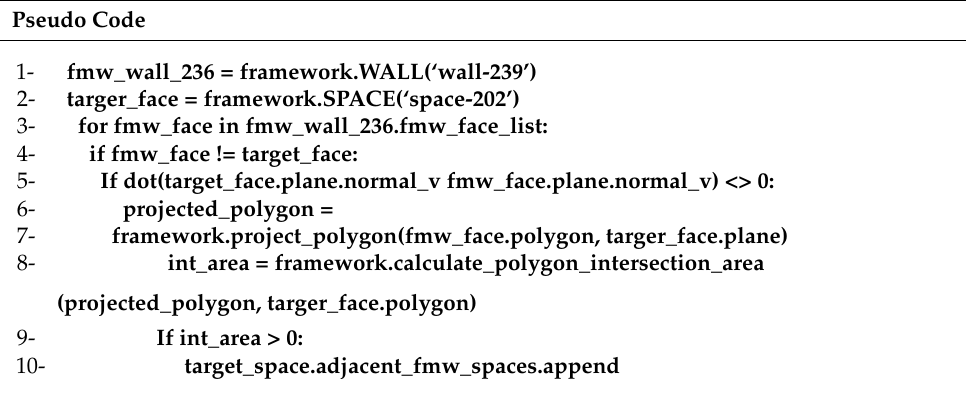
Table 5. Extracting the space’s bounded walls using semantic query. Pseudo